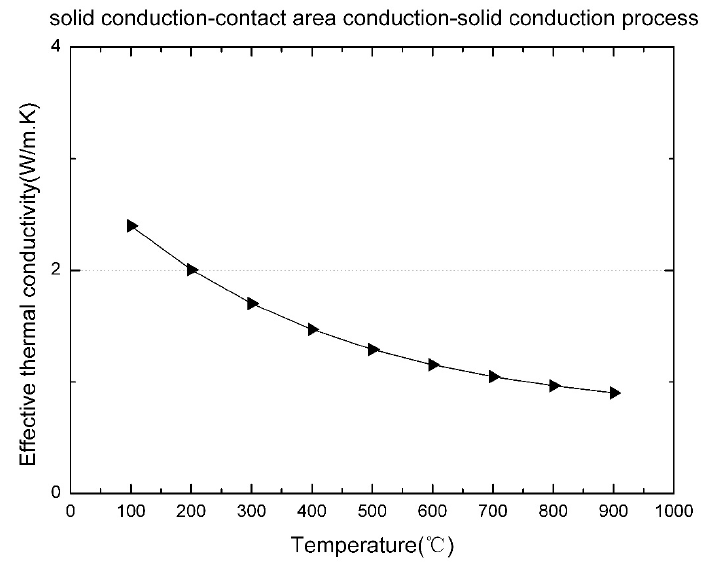
Figure 5. Effective thermal conductivity due to the solid conduction-contact area conduction-solid conduction heat transfer process.